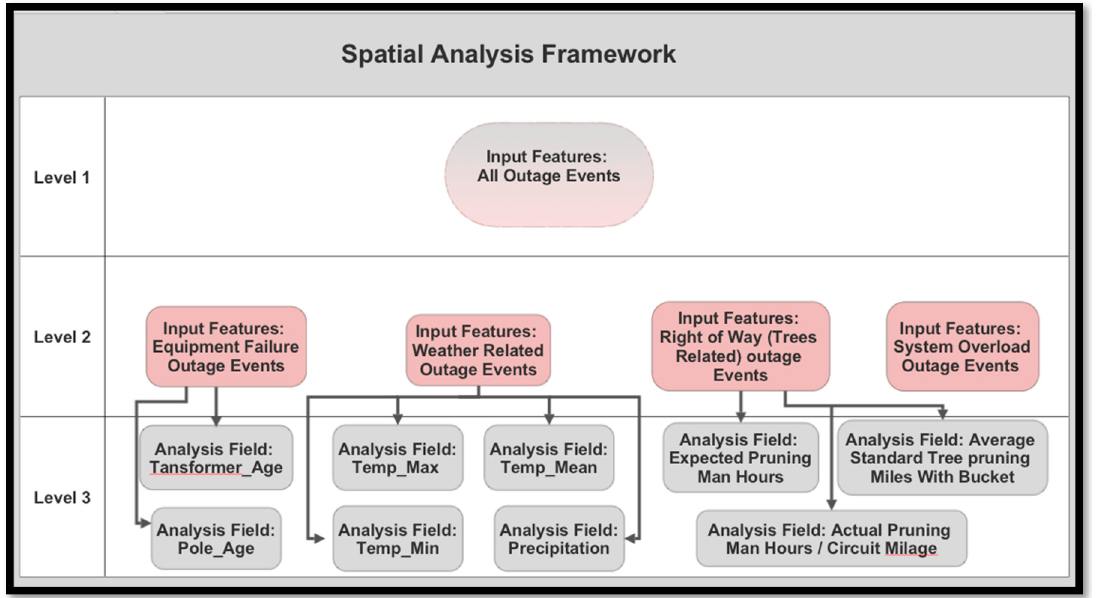
Figure 9. Spatial Analysis Framework.